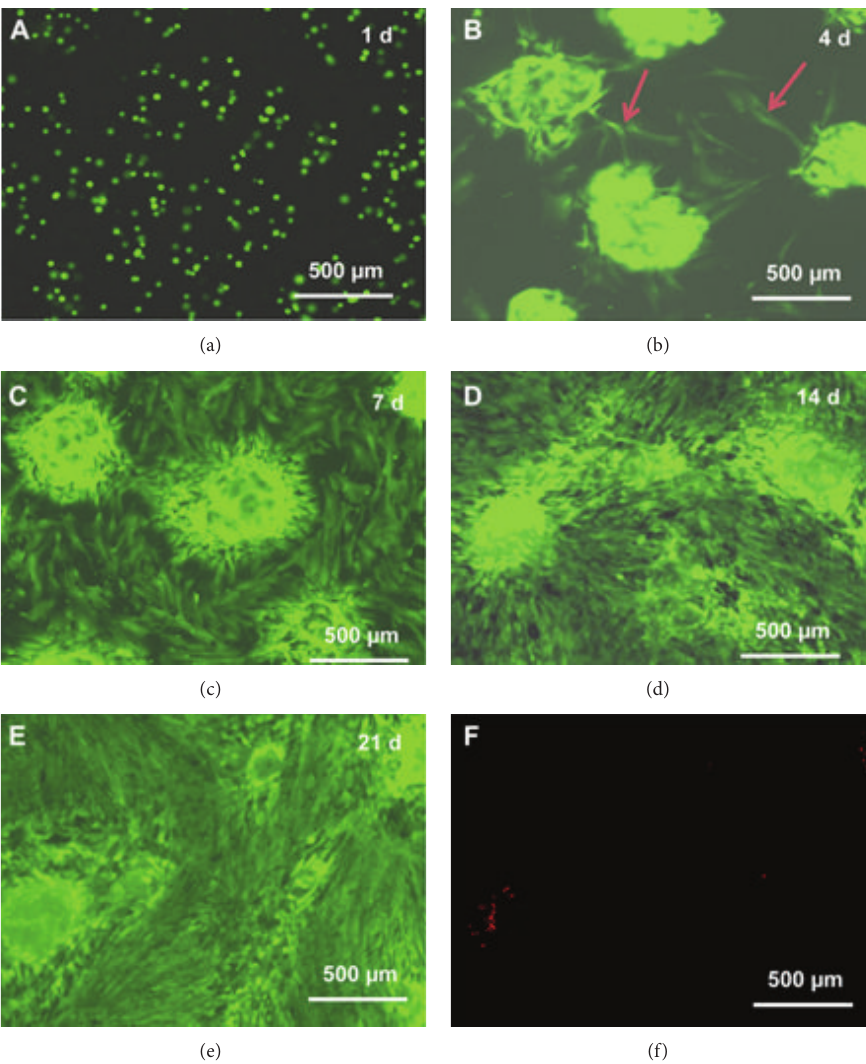
Figure 7: Fluorescent live/dead staining images. Live cells are stained in green and dead cells are in red. Cells were released from the microbeads after 4 days showing healthy polygonal morphology (arrows in (b)). After 7 days, the number of released cells increased greatly. Cells attached to the tissue culture polystyrene and showed a healthy morphology (c). Cells continued to proliferate (d) and formed confluent monolayer at day 21 (e)